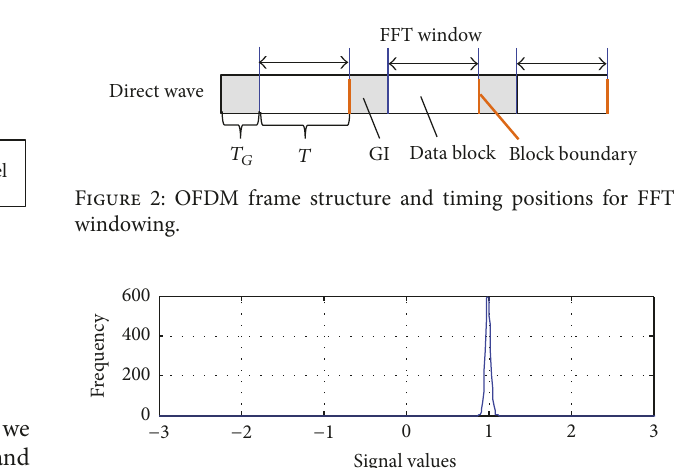
Figure 3: Received signal distribution for only direct